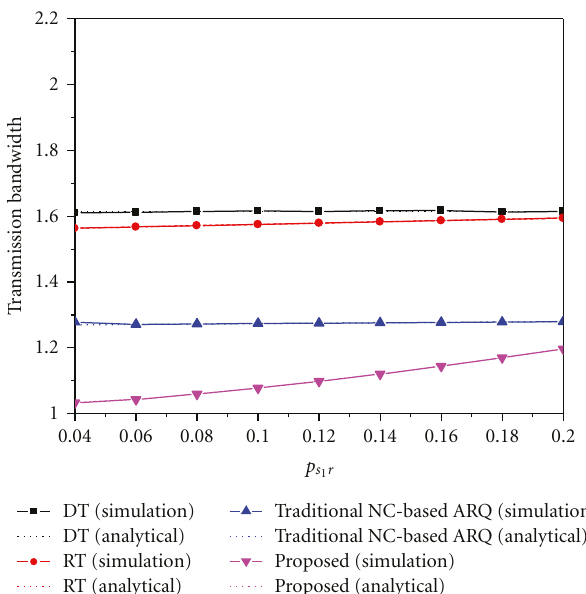
Figure 4: Transmission bandwidth of di ff erent protocols over p p p p . 2, p p . 3, and s 1 r = s 2 r with s 1 d 1 = s 2 d 2 = 0 s 1 d 2 = s 2 d 1 = 0 p p . 1. rd 1 = rd 2 = 0 Figure 5: Transmission bandwidth comparison of traditional NC- based ARQ and our proposed protocol for di ff erent values of p s